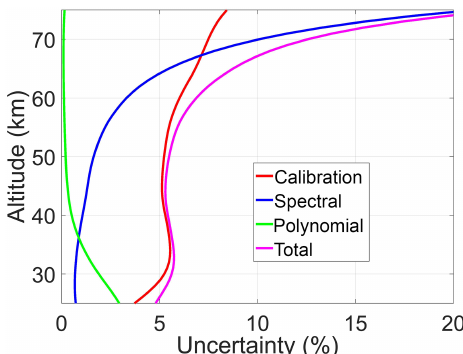
Figure 11. Vertical profiles of the calibration uncertainty (red), the retrieval uncertainty (blue), and the total uncertainty (magenta) of VESPA-22 water vapor mixing ratio vertical profiles obtained in- verting a spectrum collected on 23 December 2016 and integrated for